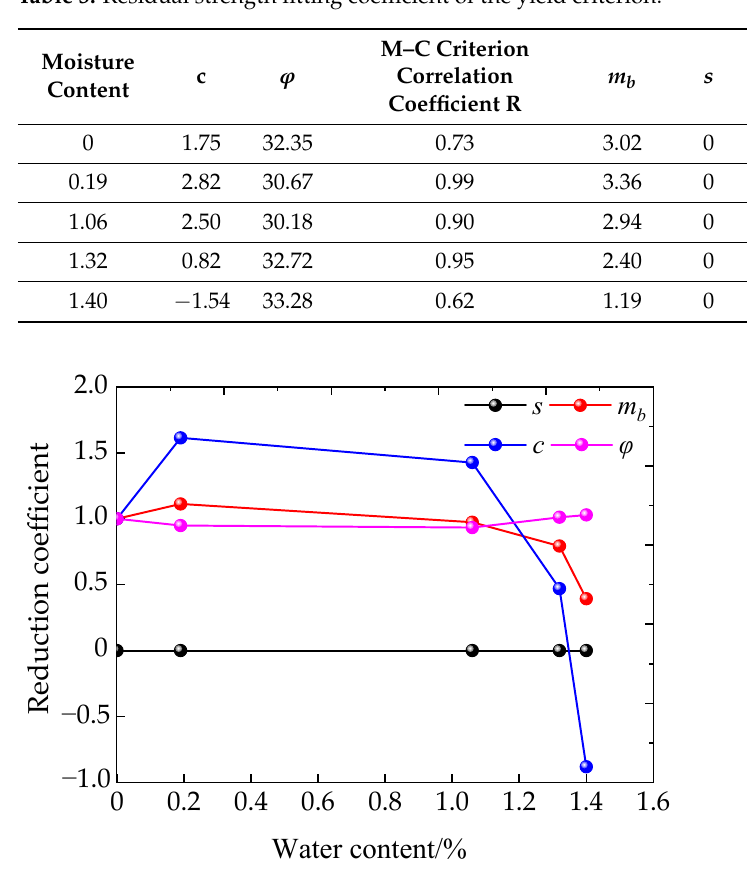
Figure 11. Plot of the reduction coefficient between the moisture content and the residual constitutive parameters.